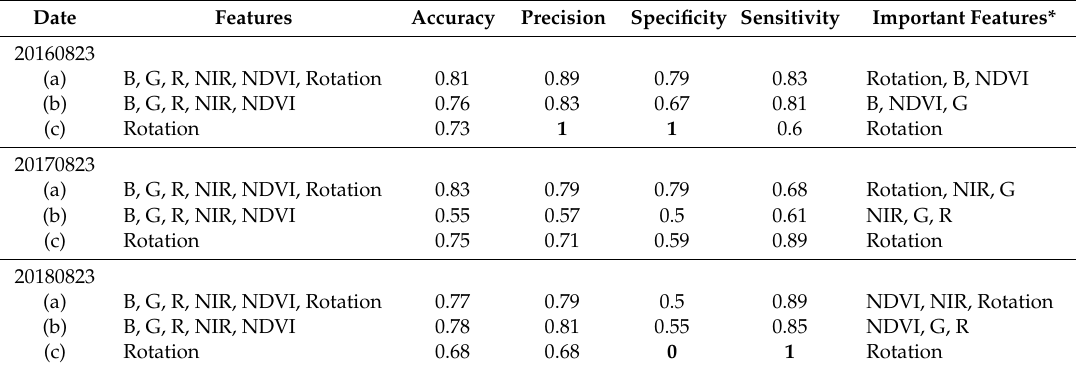
Table A1. Comparison of random forest (RF) models trained using di ff erent sets of features for three dates late in the growing season in 2016, 2017, and